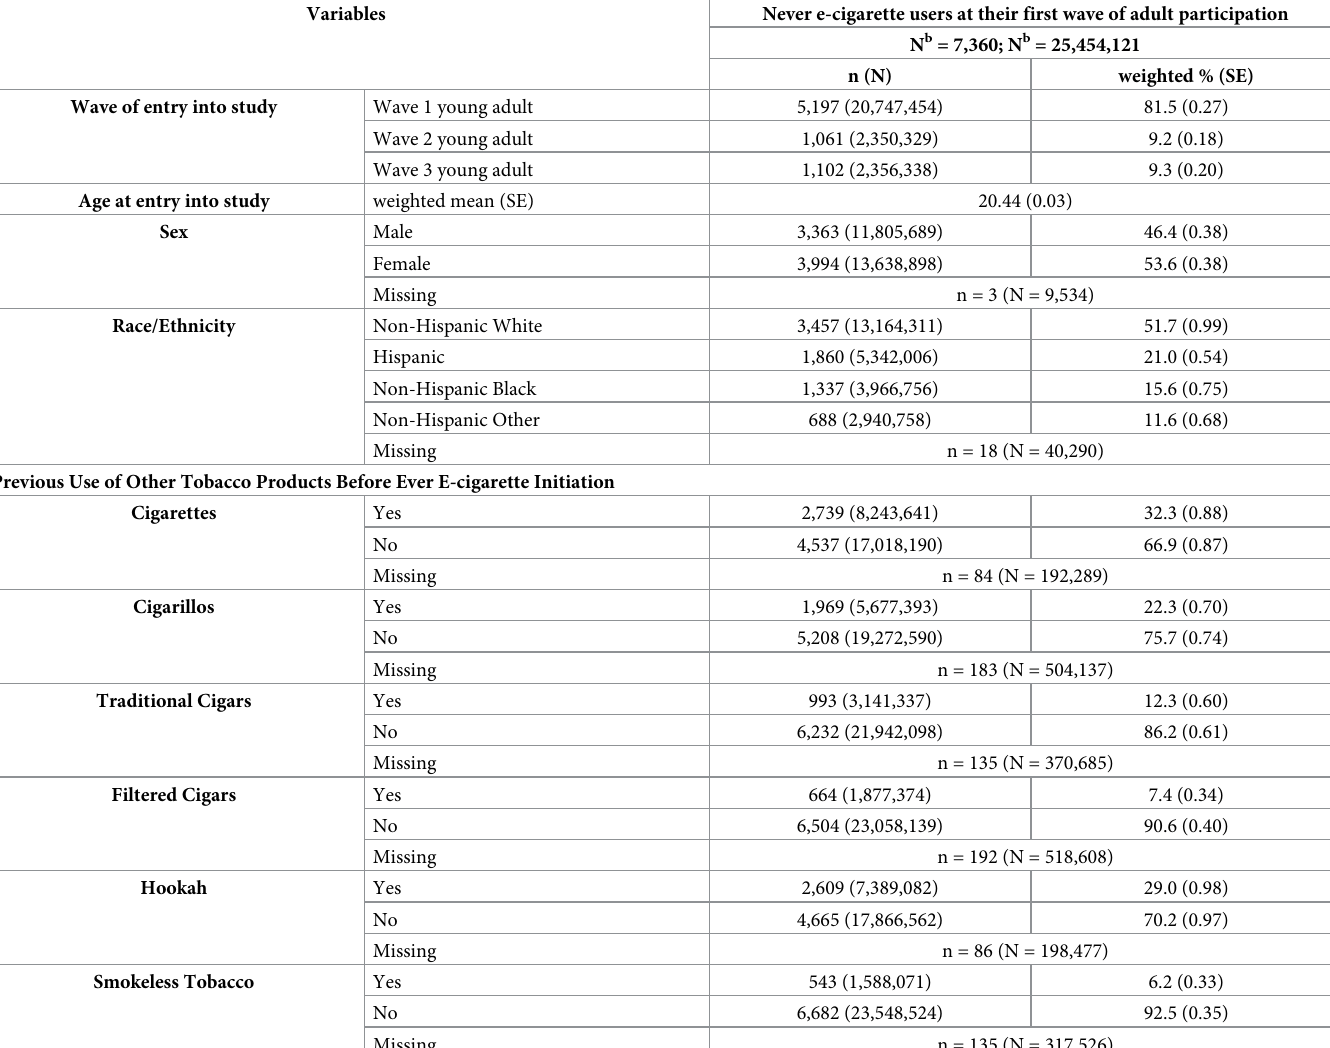
Table 1. Demographic characteristics of PATH a USA young adult (aged 18–24) never e-cigarette users at their first wave of adult participation (2013–2016). Variables Never e-cigarette users at their first wave of adult